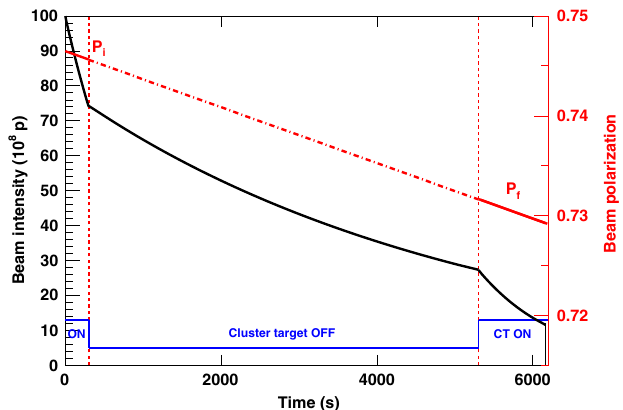
FIG. 25. Measurement cycle to determine the beam polarization lifetime. The beam polarization (red) is measured before ( P after ( P ) a waiting period of 5000 s. During the measurement, the f deuterium cluster target (CT) of the ANKE polarimeter is switched on causing a faster decrease of the beam intensity